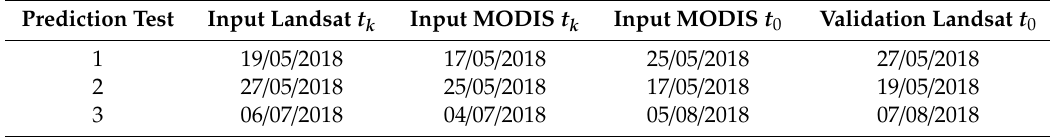
Table 1. Images used in the STARFM for